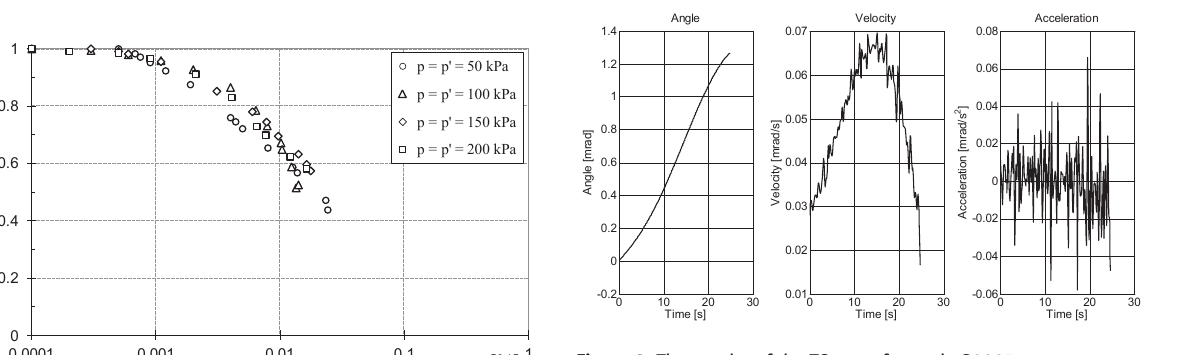
Figure 8: The results of the TS test of sample S3935. Fig. 8. The results of the TS test of sample S3935. Fig. 8. The results of the TS test of sample S3935.